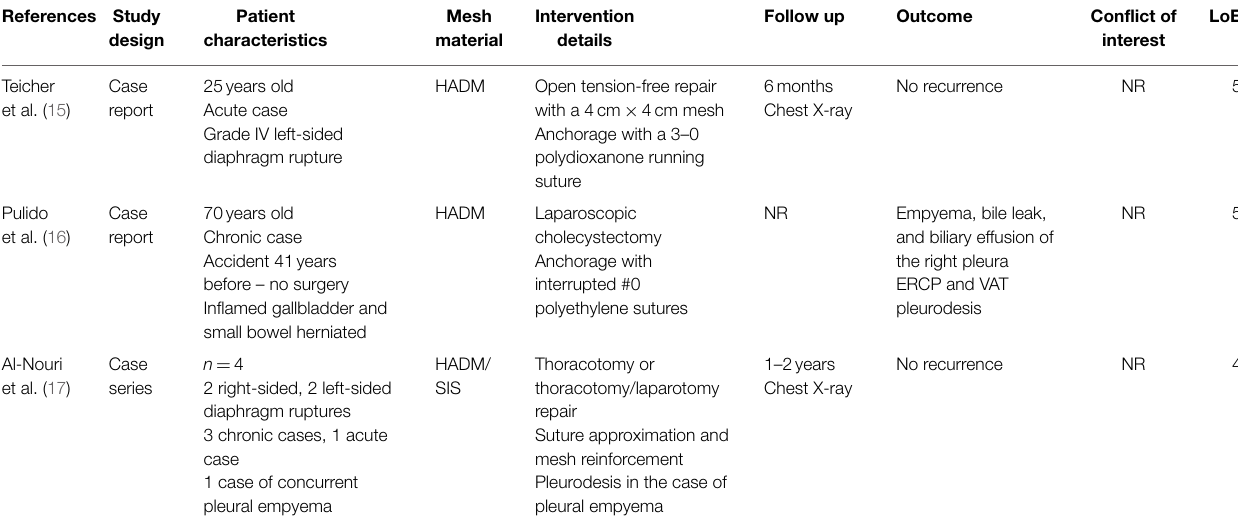
TABLE 1 | Characteristics and outcomes of studies reporting on repair of traumatic diaphragmatic rupture with the use of biologic mesh